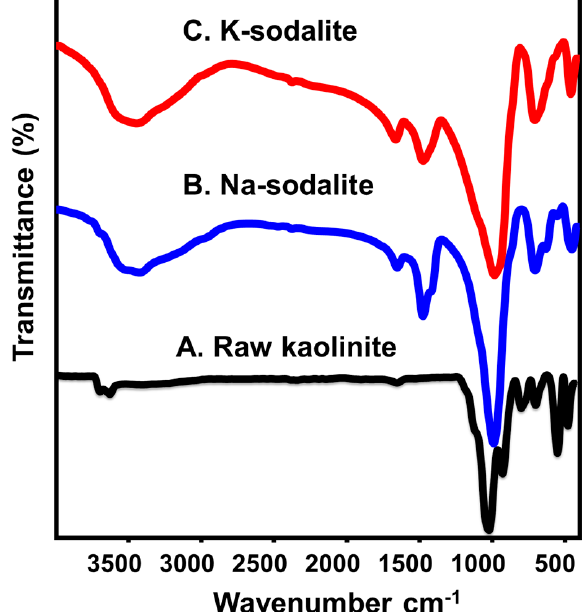
Figure 2. The FT–IR spectra of kaolinite ( A ), synthetic Na.SD ( B ), and synthetic K.SD ( C ). The reported changes in the morphology as well as in the chemical and crystalline structure significantly affected the textural and physicochemical properties of the synthetic sodalite phases (Table 1). The synthetic Na.SD phase exhibited a higher surface area (232.4 m 2 /g), ion exchange capacity (126.4 meq/100 g), and total basicity (6.3 mmol OH/g) than the determined values of K.SD (217.6 m 2 /g (surface area), 96.8 meq/100 g (ion exchange capacity), 5.4 mmol OH/g (total basicity)) (Table 1). While the high surface area and total basicity of the Na.SD compared to those of the K.SD induced the former’s catalytic activity, its high ion exchange capacity might have been caused by adverse and saponification effects during the transesterification